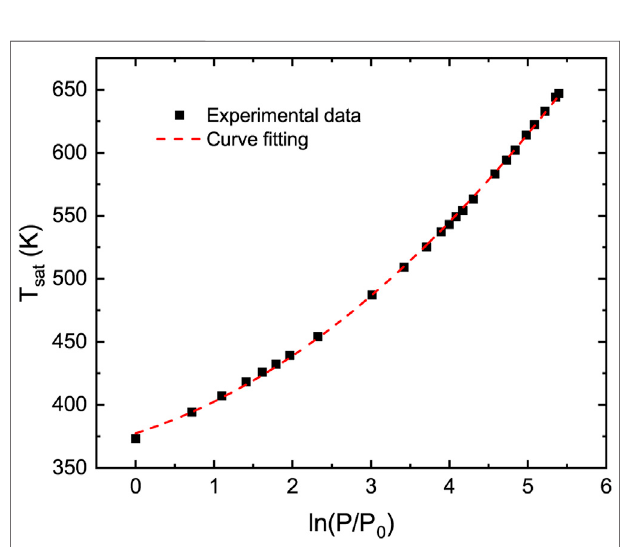
FIGURE 8 | Saturation temperature of water under different